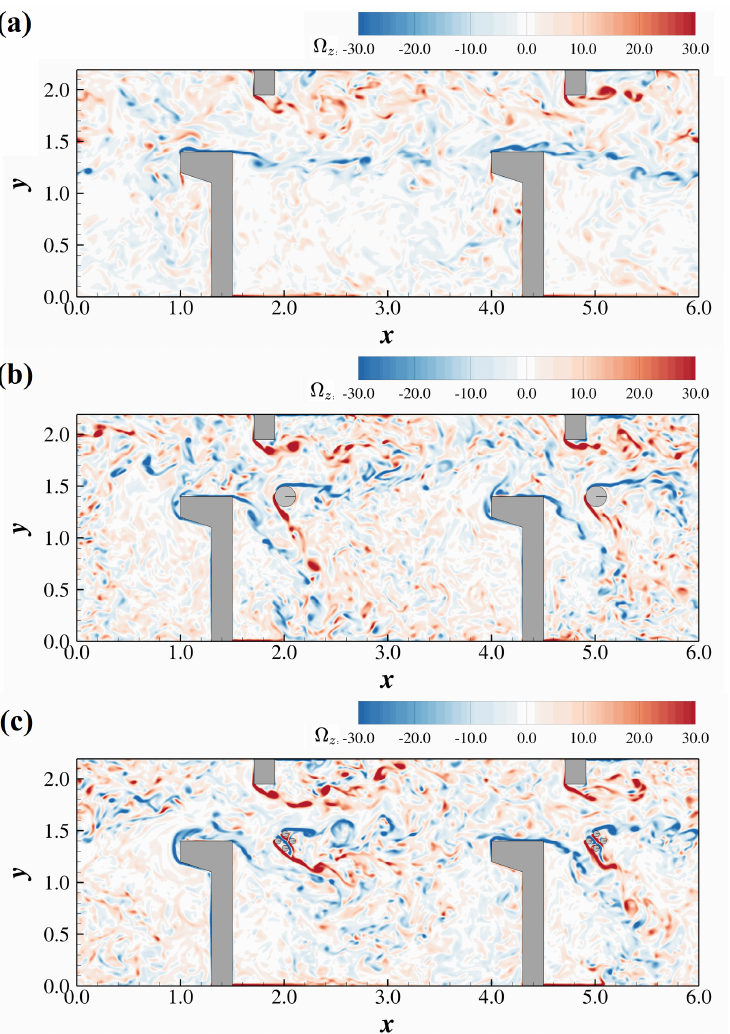
Figure 8. Contours of turbulence kinetic energy in a the horizontal plane at half height of: ( a ) Case 1; ( b ) Case 2; ( c ) Case